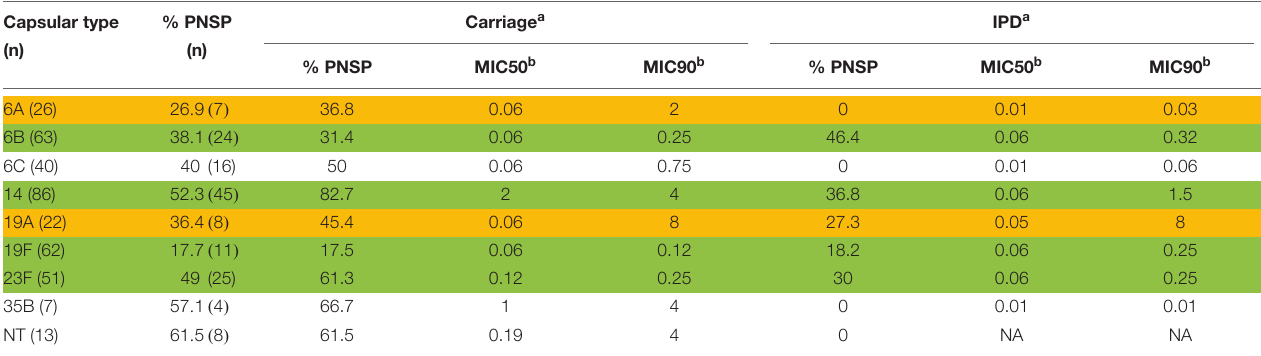
TABLE 3 | Distribution of Streptococcus pneumoniae isolates non-susceptible to penicillin (PNSP) among nine capsular types mostly associated with penicillin resistance, according to the clinical source. Capsular type